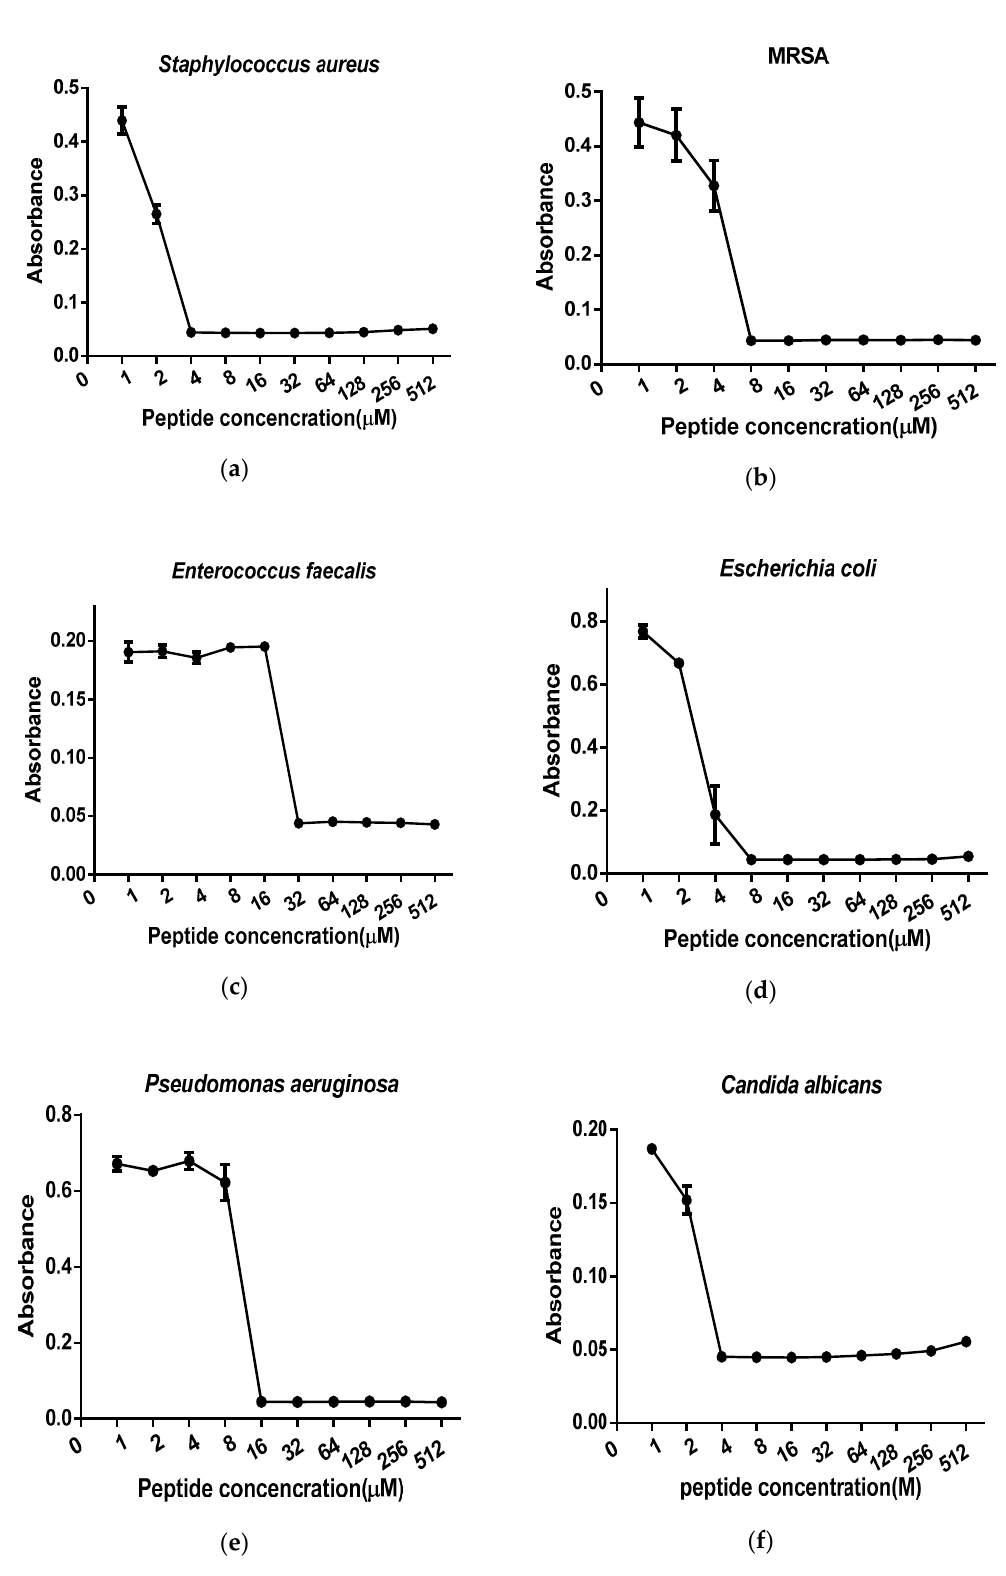
Figure 5. Minimum inhibitory concentrations (MICs) curves obtained following incubation of Der-PS4 with S. aureus ( a ), MRSA ( b ), E. faecalis ( c ), E. coli ( d ), P. aeruginosa ( e ) and C. albicans ( f ) in a range of concentrations from 1 µM to 512 µM. Data represent means ± SEM (standard error of the mean) of 5 replicates.